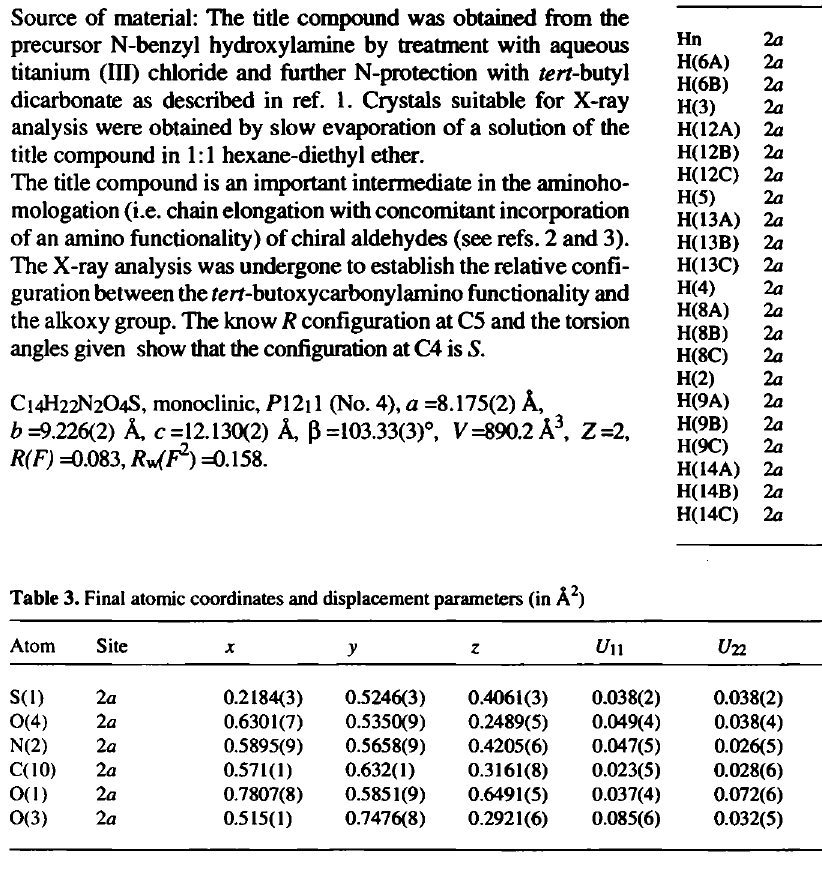
Table 2. Final atomic coordmates and displacement parameters (in A^)